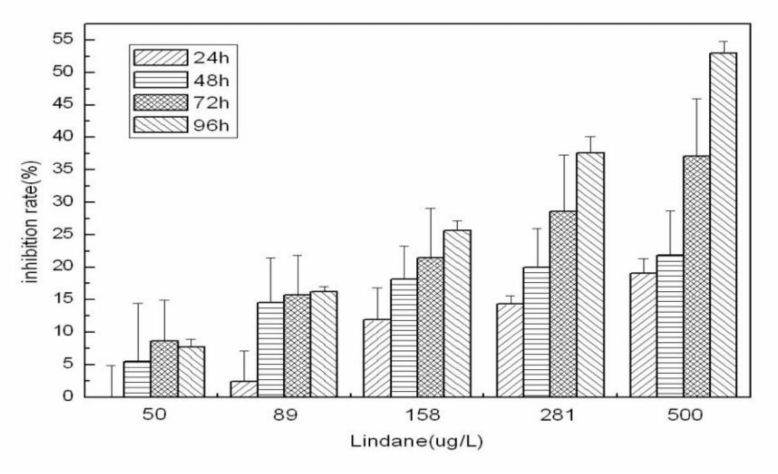
Figure 1. The growth inhibition of Microcystis aeruginosa by Lindane. Each value is the mean ± S.D.